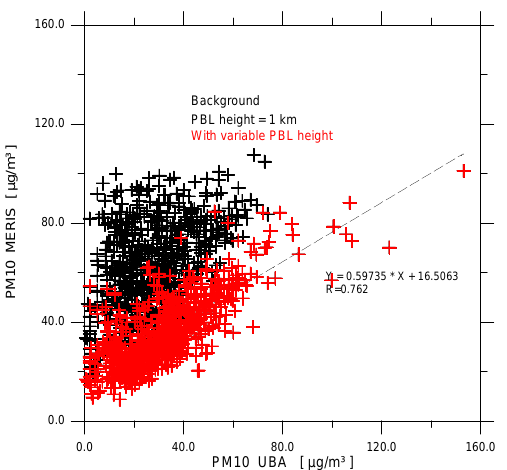
Fig. 11. Comparisons of PM 10 as retrieved from 250 Fig. A11. Comparisons of PM 10 as retrieved from 250 M ERIS /P MBAER and national air quality measurements over rural M ERIS /P MBAER and national air quality measurements over rural sites in Germany. Results with and without inclusion of E CMWF sites in Germany. Results with and without inclusion of E CMWF planetary boundary layer heights (P BL ) are shown planetary boundary layer heights (P BL ) are shown here.